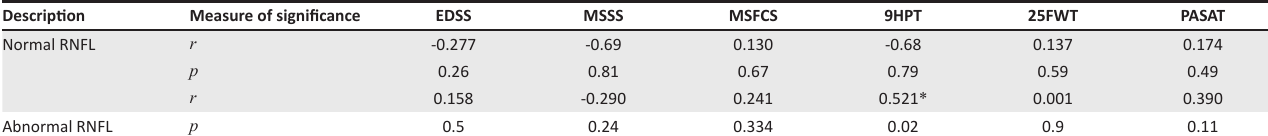
TABLE 4: Retinal nerve fibre layer thickness categories correlation with different measures of disability in patients with multiple sclerosis. Description Measure of significance